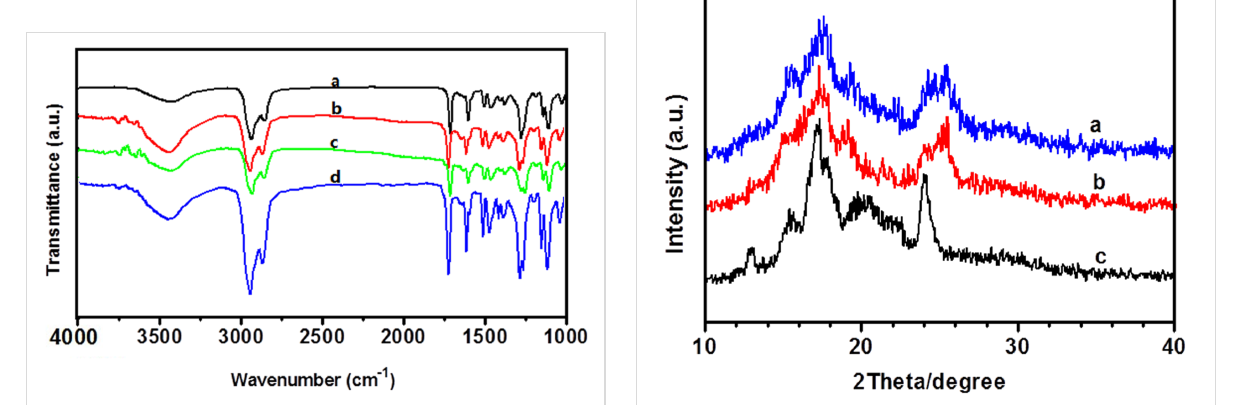
observed at 3437cm − 1 can be assigned to the intermolecular association hydrogen stretching vibration. However, the band of ethanol, isopropanol and 1-butanol shifted to 3438, 3439 and 3440 cm − 1 , respectively. The comparison of the IR spectra of powder and gels indicated the hydrogen-bond interaction in the gels. The bands of the asymmetric and symmetric CH 2 stretching vibration of M 6 powder emerged at 2935 and 2852 cm − 1 , while, in the ethanol gel, they shifted to 2934 and 2858 cm − 1 , in isopropanol gel, they shifted to 2934 and 2862 cm − 1 , in 1-butanol , they shifted to 2933 and 2859 cm − 1 . The above mentioned FTIR spectral changes demonstrated sufficiently that van der Waals interaction between the alkyl chains plays an important role in the self-assembly process of organogels.